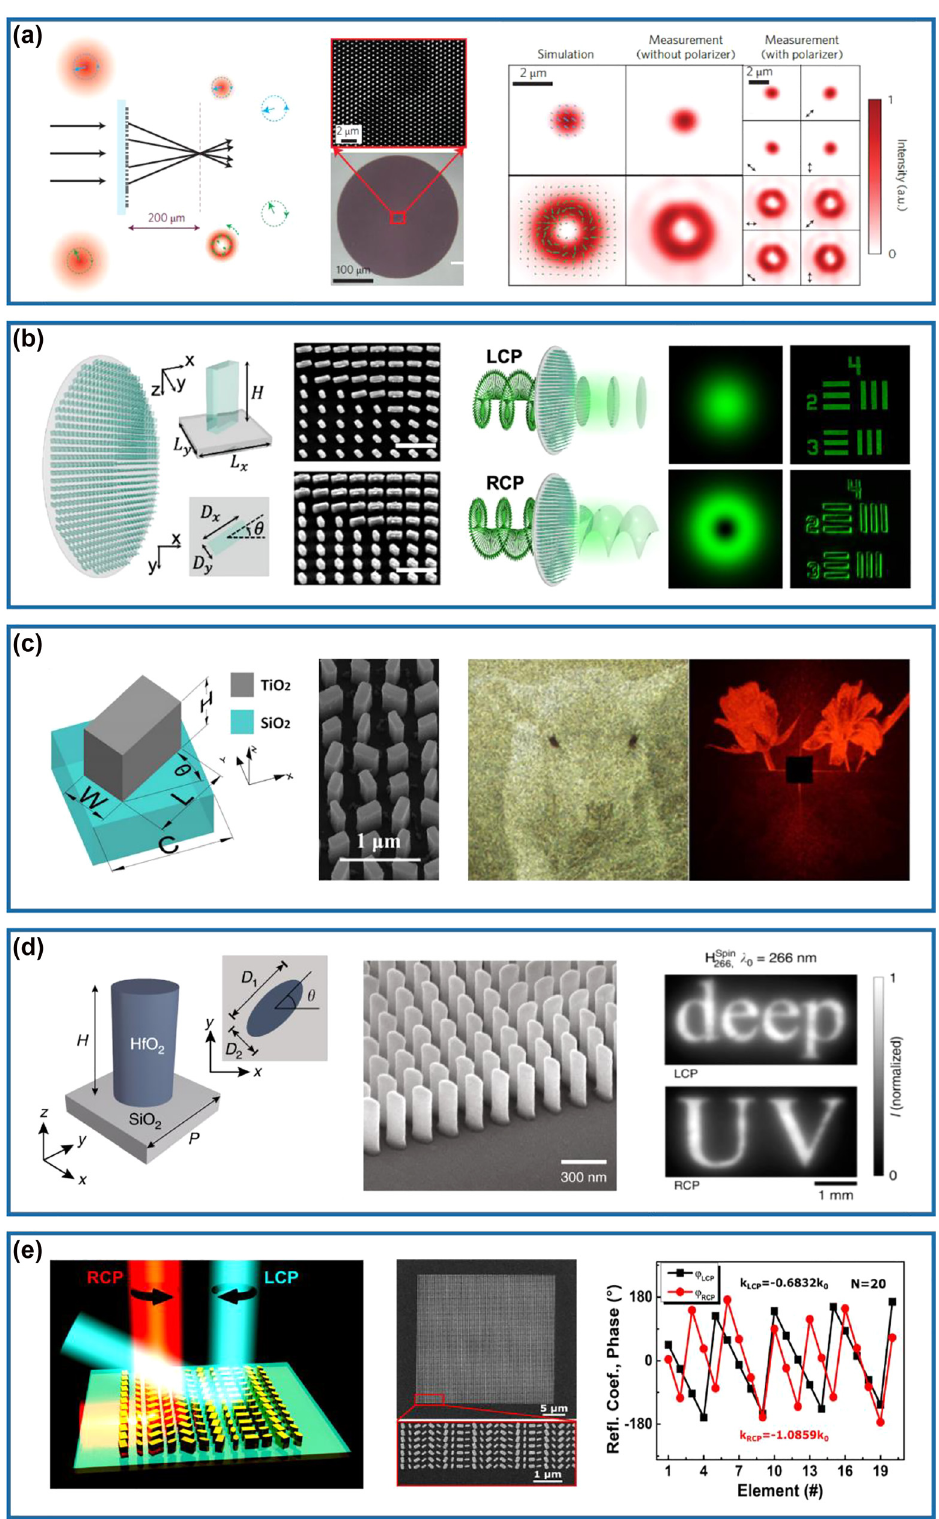
Figure 4: Multifunctional meta-HWPs using both resonance and geometric phases. (a) Left panel: schematic of the Si metasurface that can selectively focus the RCP and LCP light into a nearly diffraction-limited spot and a donut-shaped intensity pattern. Middle panel: SEM and optical microscopeimages of the fabricated sample.Right panel: simulatedand measuredintensity profiles. Reprinted from Ref. [46]. (b)